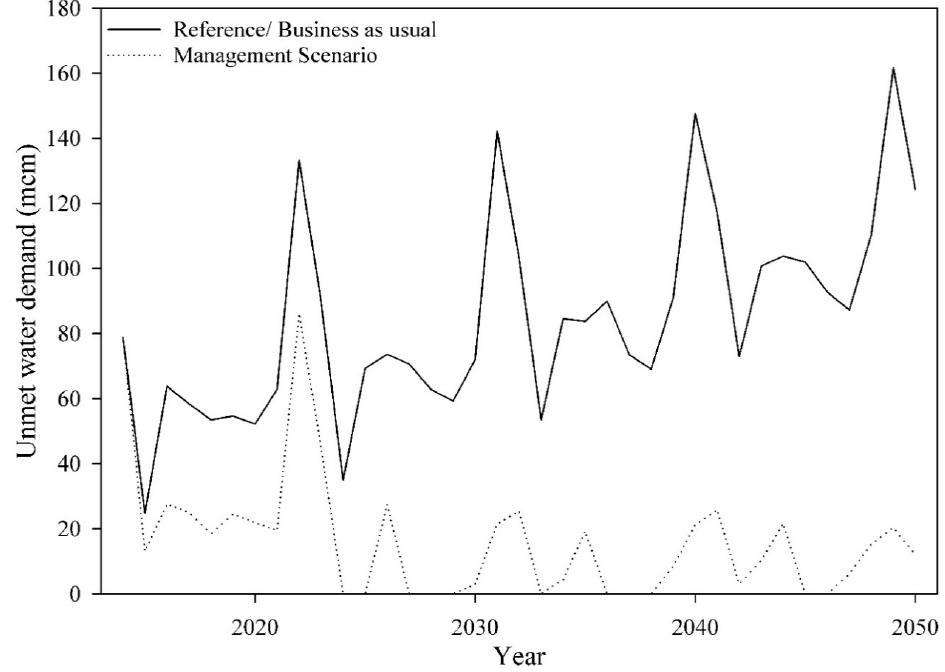
Figure 15. The projection of unmet water demands in the Upper Indus Basin (UIB) under the reference and water management